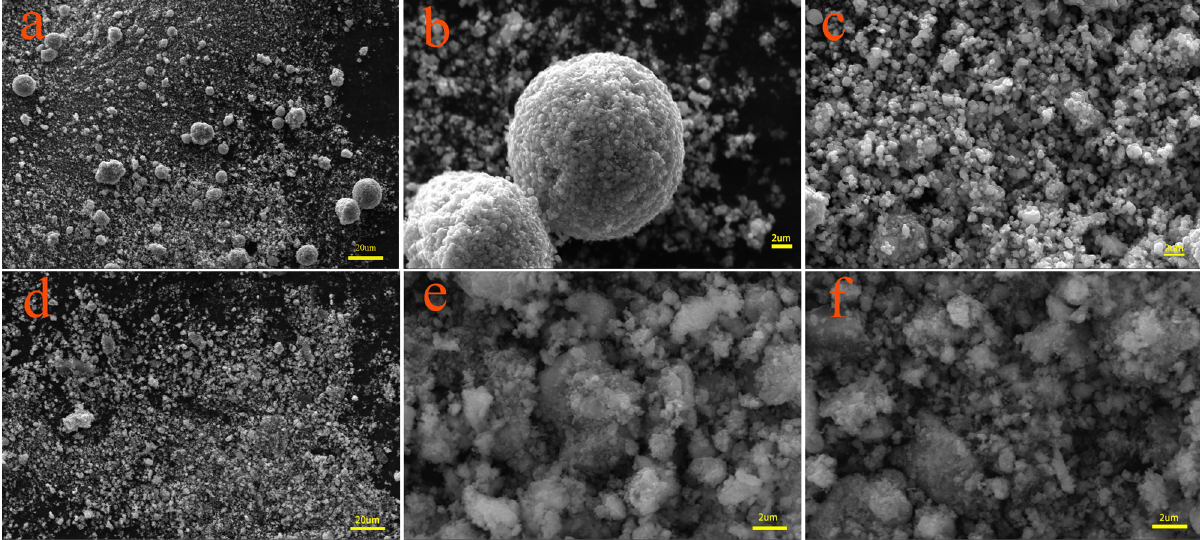
Figure 3: SEM Graph: LiFePO 4 materials, ( b ) the primary particles of LiFePO 4 materials, ( c ) the secondary particles of LiFePO 4 materials, ( d ) the acid slag, ( e ) the secondary particles of the acid slag are absent, ( f ) the primary particles of the acid slag broken apart into smaller irregular shapes.